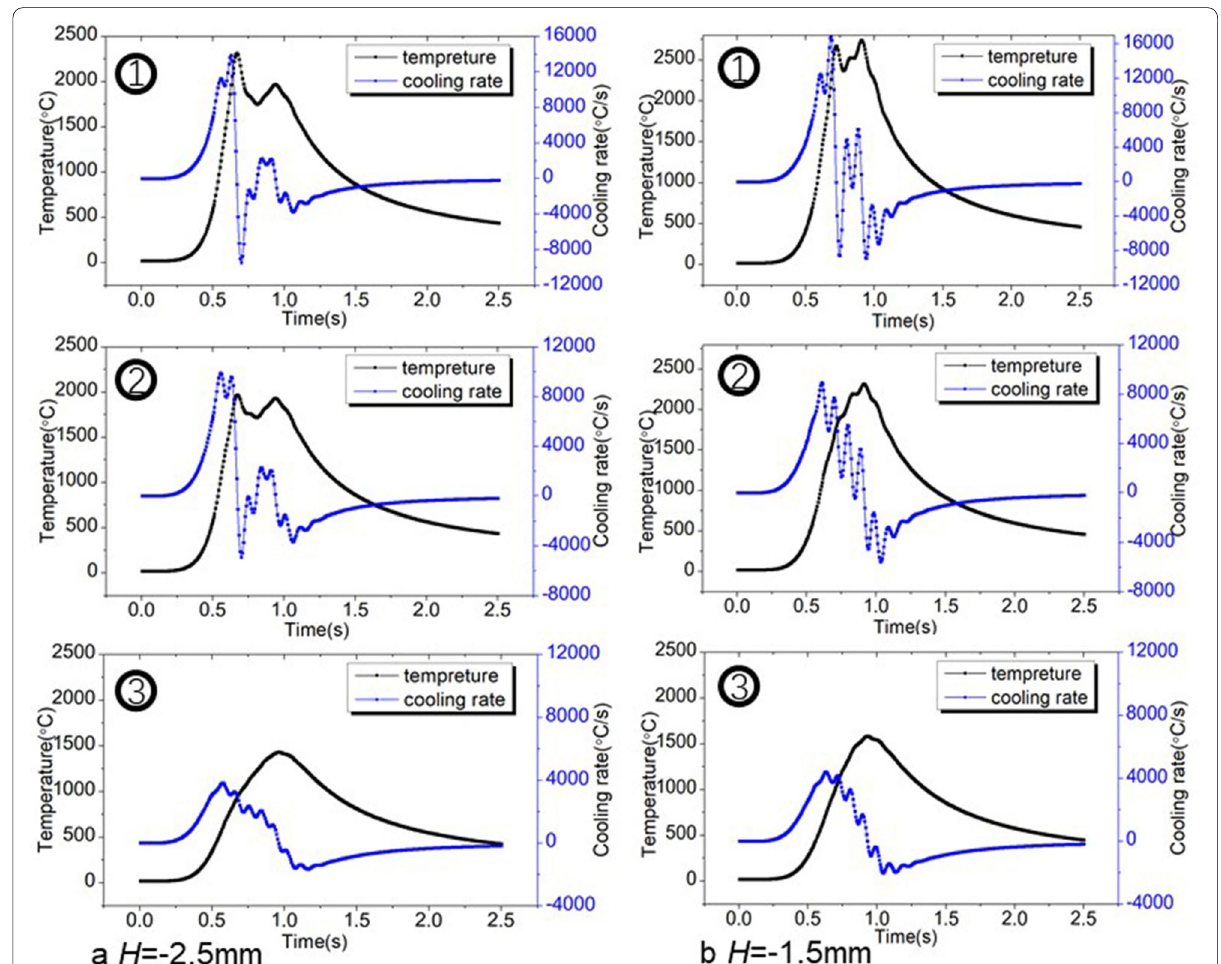
Figure 20 Temperature histories and cooling rate evolutions: a H bottom of